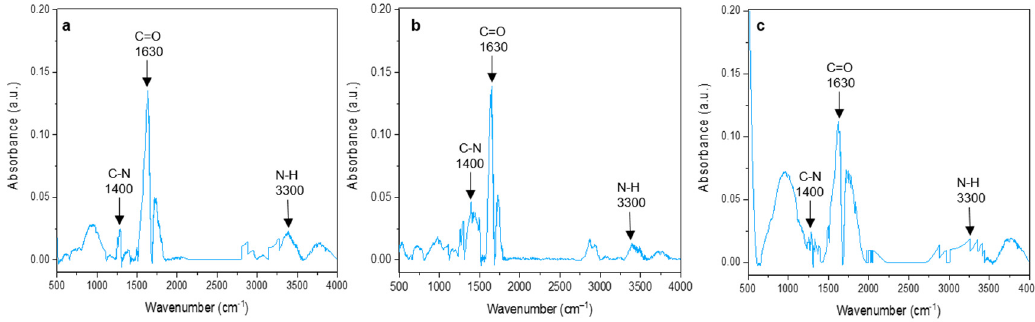
Figure 5. FTIR of three different conjugates of MWCNT/PANI at ratios of 3:1 ( a ); 6:1 ( b ); 10:1 ( c ).